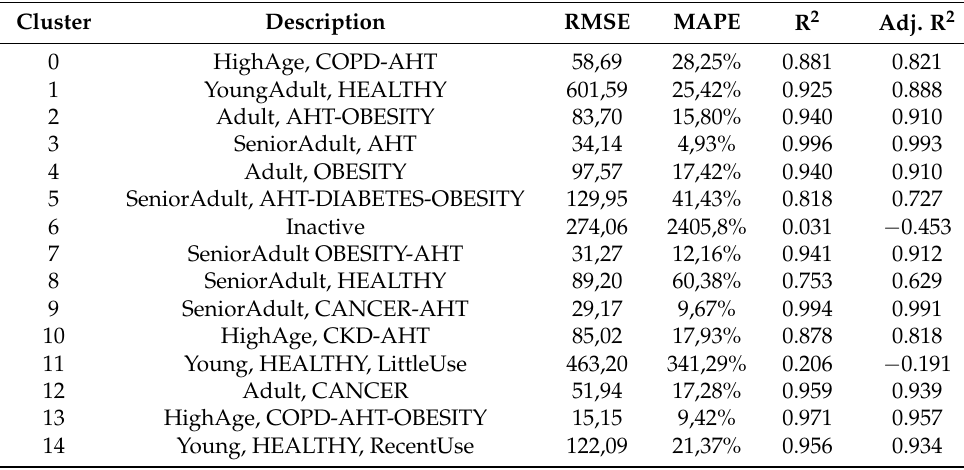
Table 11. LSTM network model results after segmenting